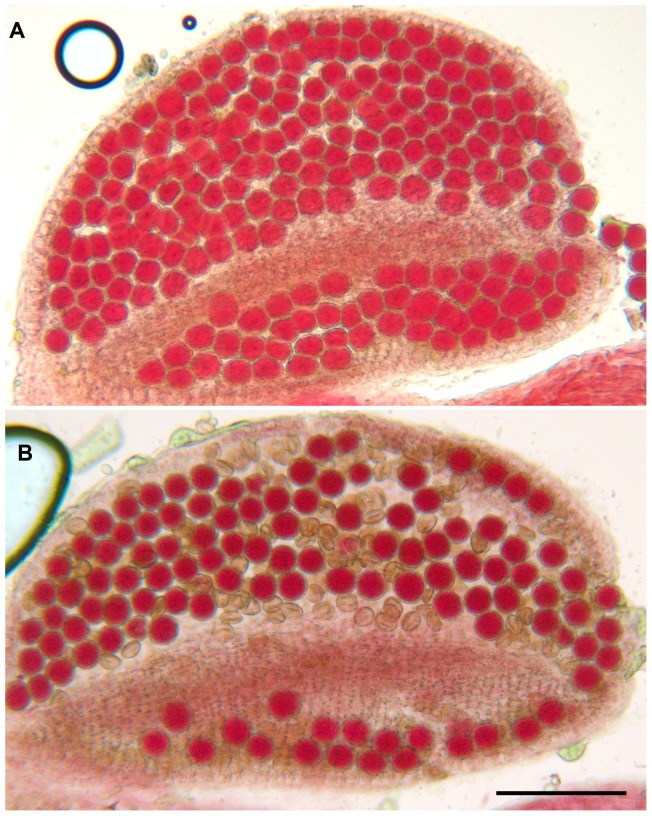
Alexander staining.(A) A wild type anther containing pollen grains that are all viable, as indicated by their red staining and round shape. (B) An Atmcm8-1 anther containing viable and dead pollen grains as indicated by their abnormal shapes and green coloration. Bar, 100 µm.